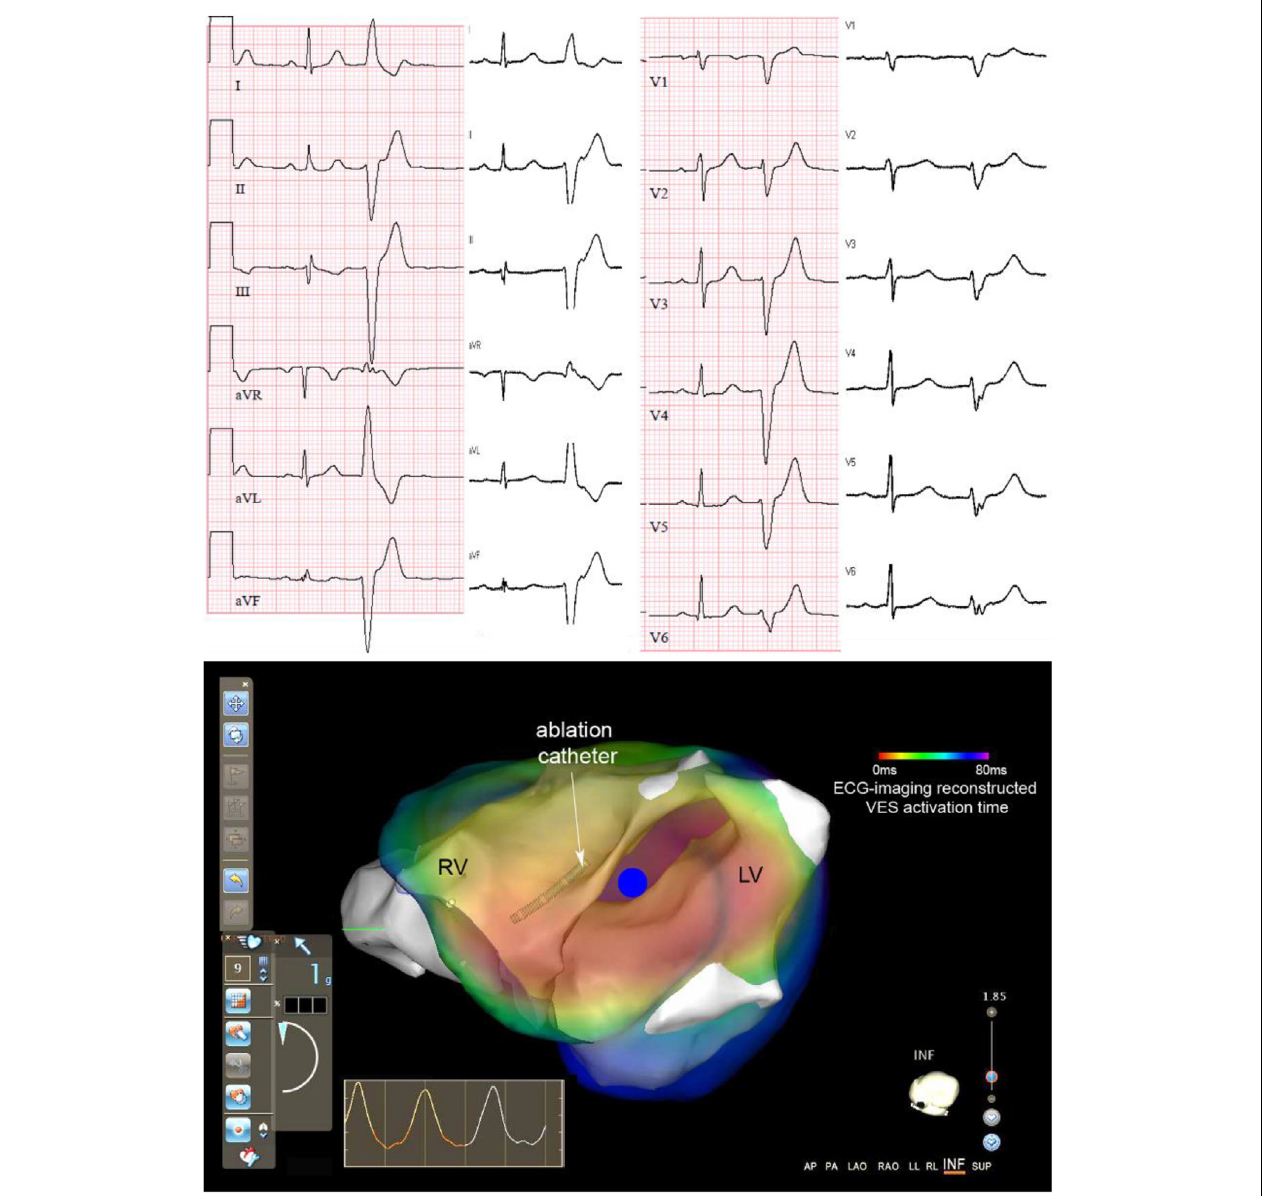
FIGURE 7 | Example of ECGI-guided ablation in a patient. Top: 12-lead ECG recorded during ECGI (white background) and clinical recording during symptoms (pink background), both with a sinus beat and subsequent premature ventricular complex (PVC). Bottom: Live view as visible to the cardiologist-electrophysiologist during the ablation procedure when using the Carto 3 cardiac mapping system. The 3D anatomy as determined by the Carto catheter (white structures) is overlaid with the activation map of the PVC as created pre-procedurally with ECGI (red-to-blue: early-to-late activation time; blue dot: PVC origin). The cardiologist can use this live view during the procedure to navigate the catheter to the area suspected of the PVC origin. Adapted with permission from: Cluitmans et al.